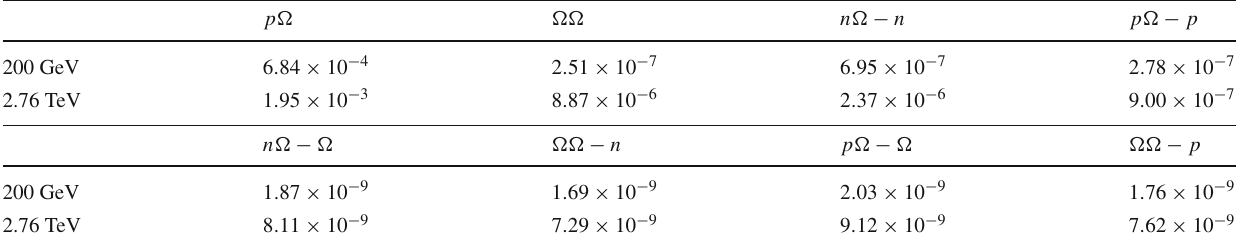
Table 6 dN / dy for (cid:3) -dibaryons and hypernuclei at midrapidity. The values of dN / dy for (cid:3) -dibaryons are taken from Ref. [19] Table 7 dN / dy for (cid:3) -dibaryon and hypernuclei at midrapidity calculated by the folding model. The values of dN / dy for (cid:3) -dibaryons are re-calculated in this work